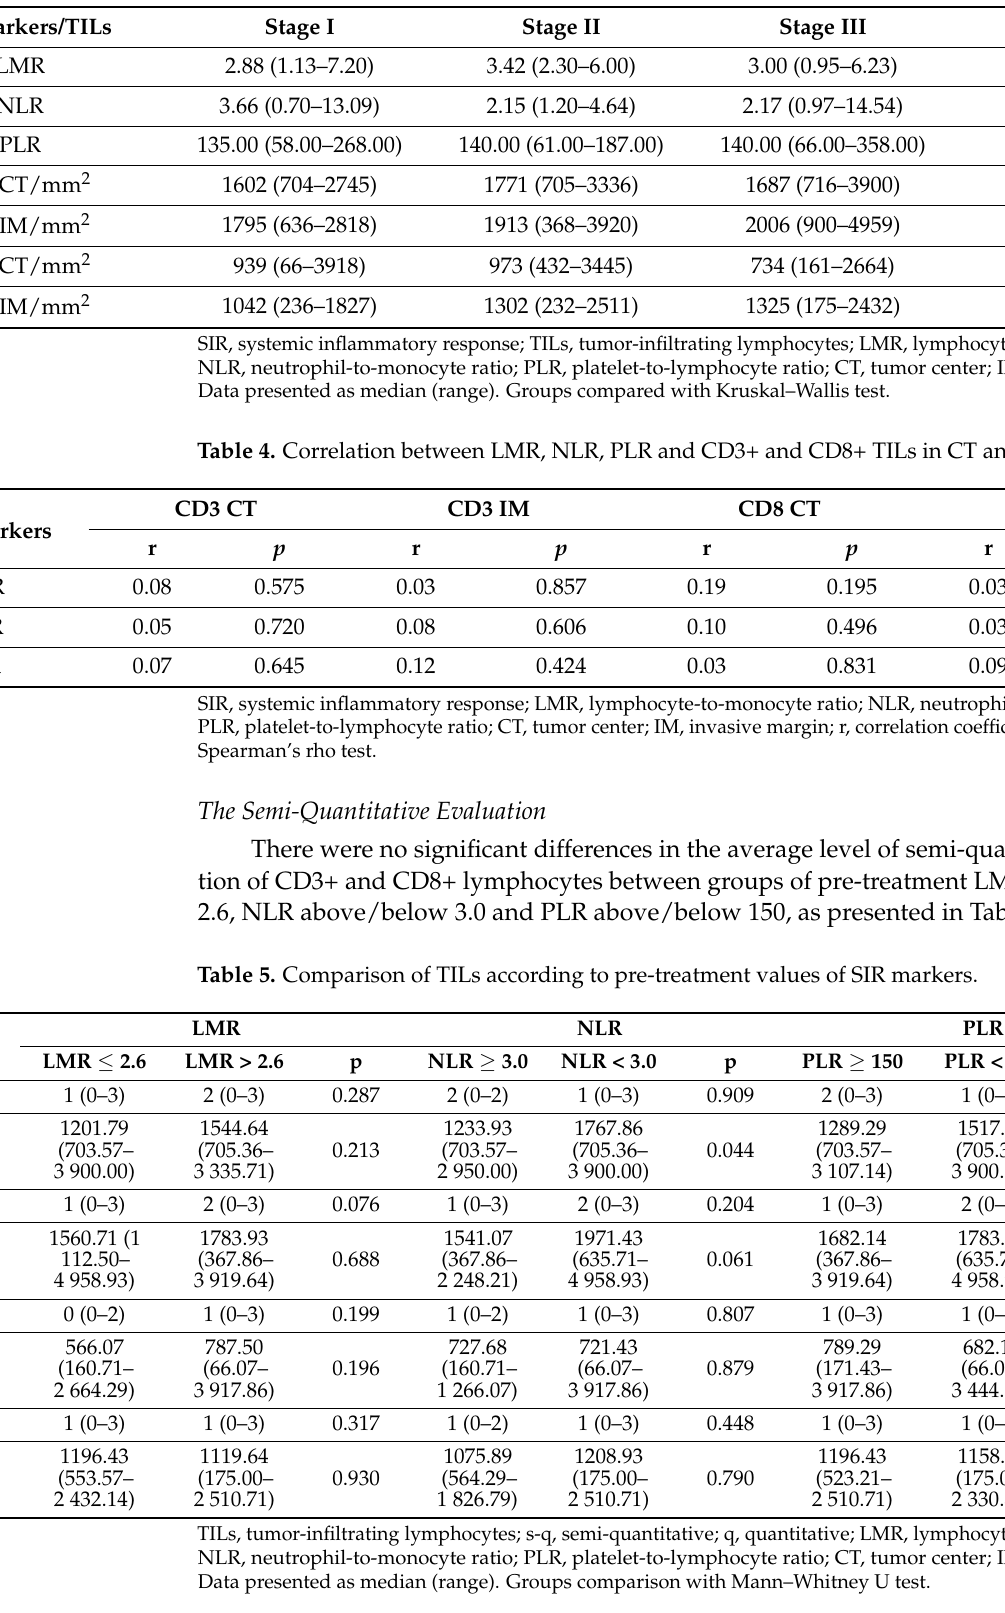
Table 3. Comparison of SIR markers and TILs according to the stage of the disease.